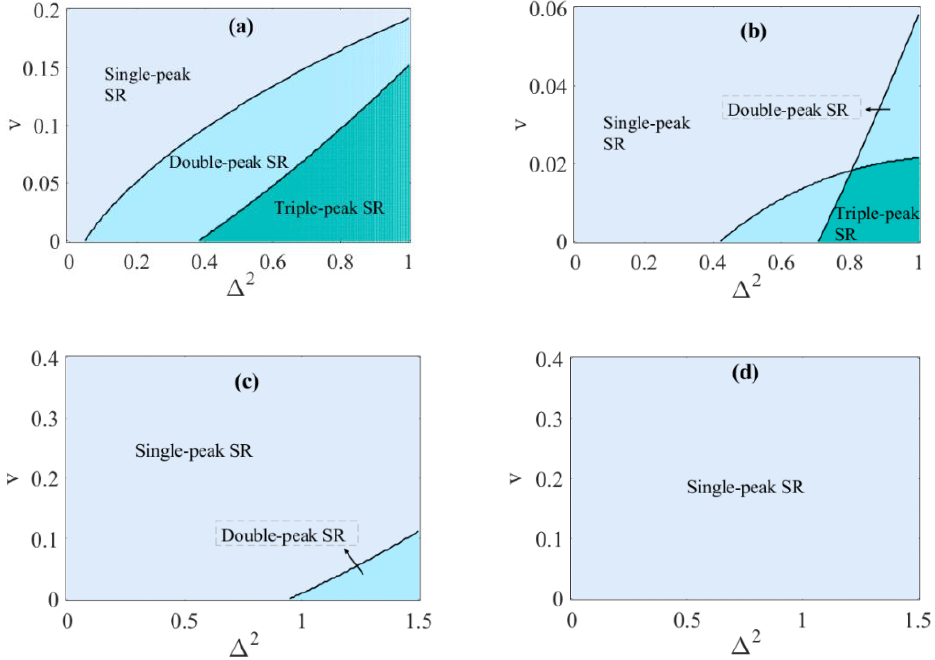
(cid:0) (cid:1) v , ∆ 2 under ( a ) q = 0.1, () 2 , v  under ( a ) 0 . 1 q = , ( b )